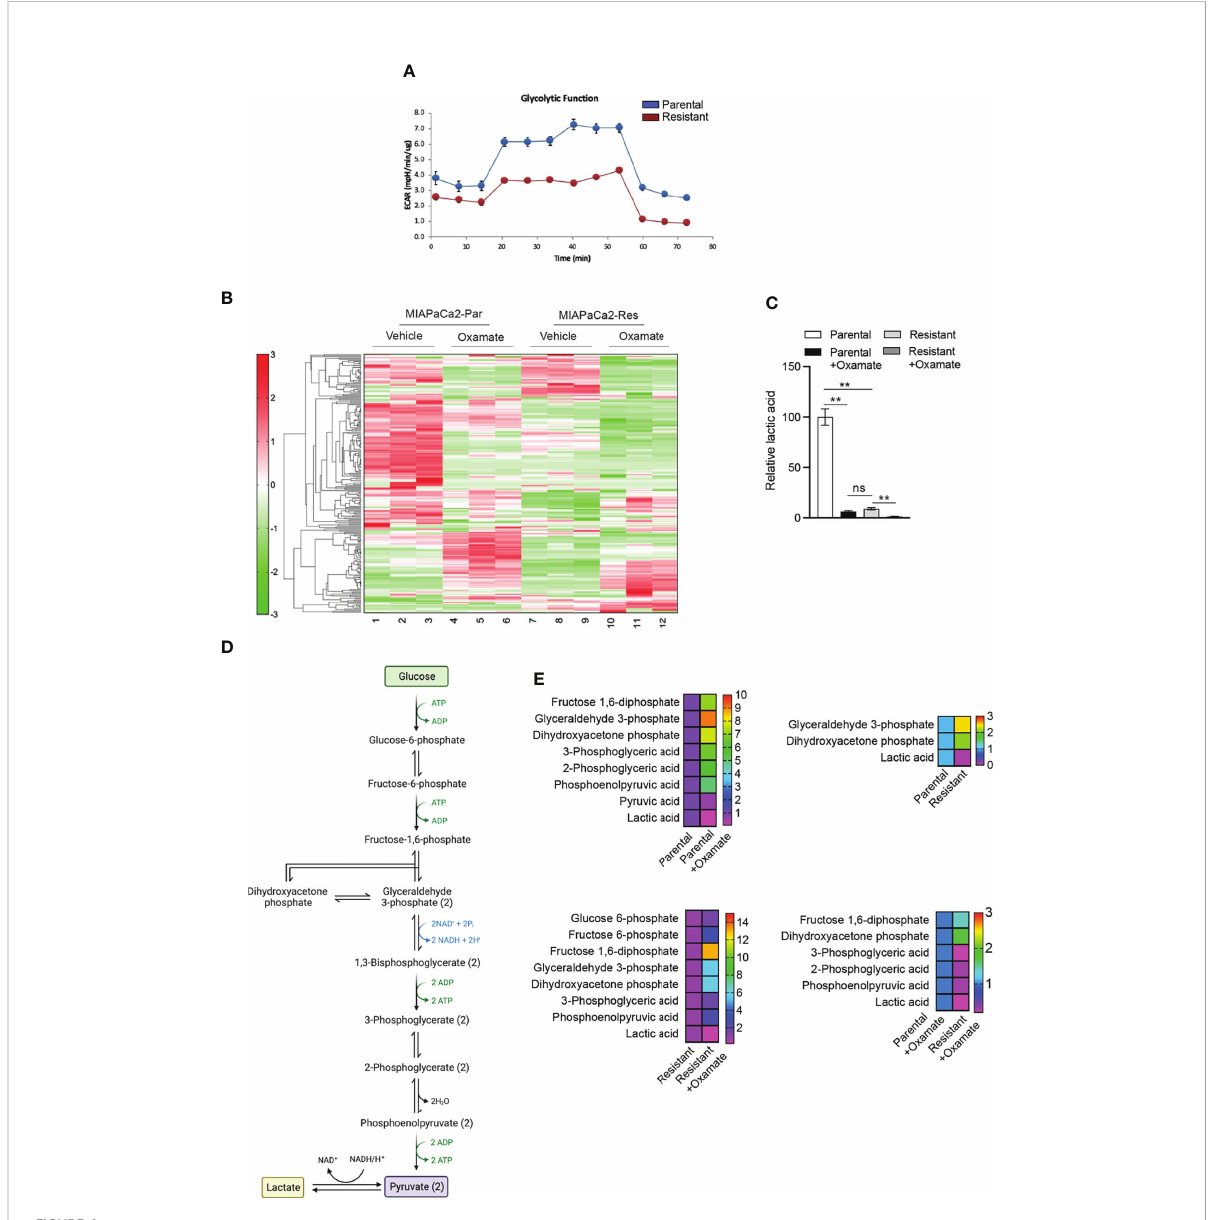
FIGURE 4 Metabolic pro fi ling of parental and oxamate-resistant cells treated with or without sodium oxamate. (A) Seahorse analysis of the glycolysis stress test measuring the glycolytic functions of parental and oxamate-resistant cells. Extracellular acidi fi cation rates for parental and oxamate- resistant MIAPaCa2 cells are shown. (B) Heatmap showing differences in metabolite levels among parental (Par) and oxamate-resistant (Res) MIAPaCa2 cells treated with vehicle or oxamate. (C) Relative lactic acid levels in parental and oxamate-resistant cells treated with and without oxamate are shown. (D) Schematic showing glycolysis and the step for pyruvate to lactate conversion. (E) Changes in the indicated metabolites involved in glycolytic pathways under the indicated